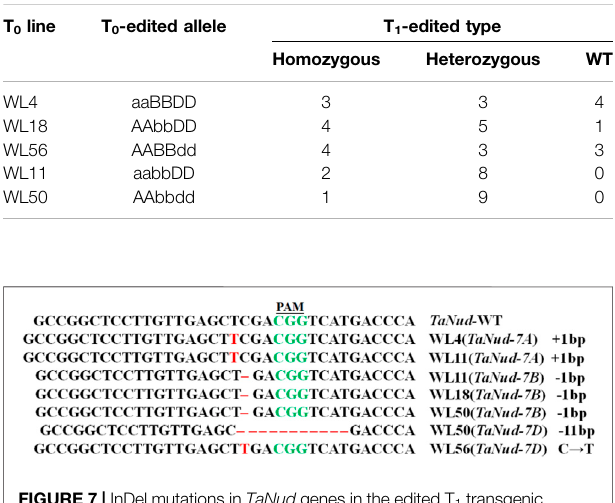
Frontiers in Genetics |